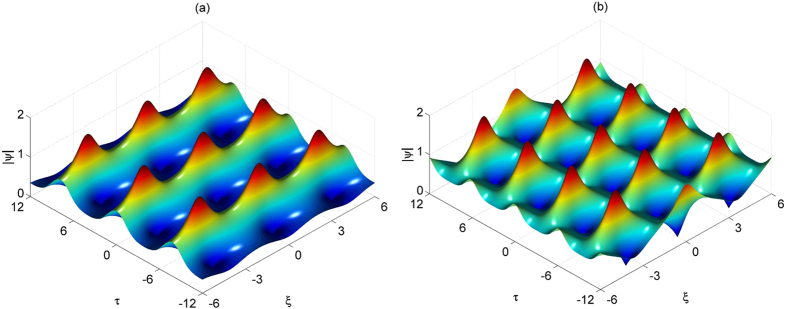
(a) NLSE periodic solution as described by Eq. (2) for κ = 0.7. (b) NLSE periodic solution as described by Eq. (6) for k = 0.8.